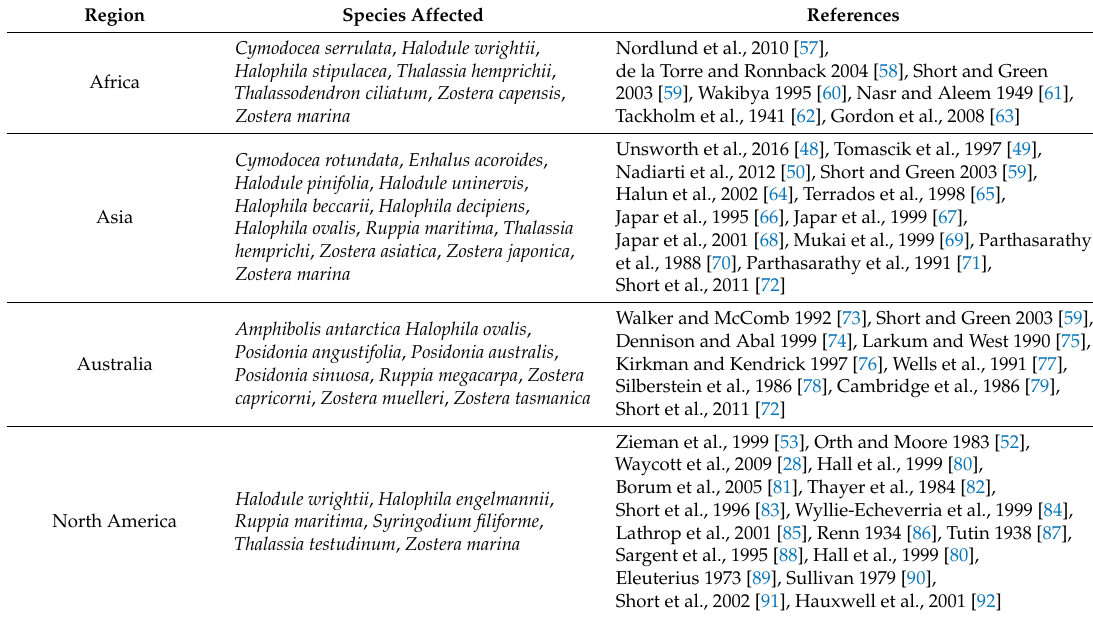
Table 1. List of seagrass species affected by die-off events in different regions of the world.